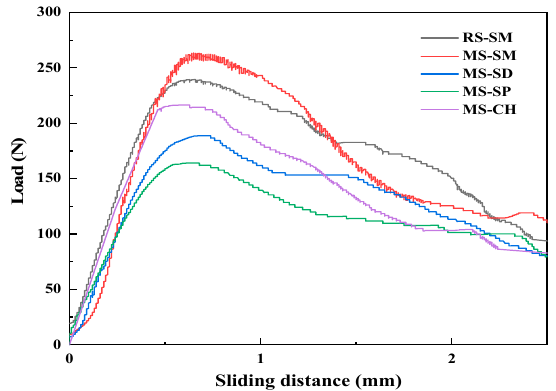
Figure 8. Load-slip curve of steel fiber and UHPC Figure 8. Load ‐ slip curve of steel fiber and UHPC matrix.